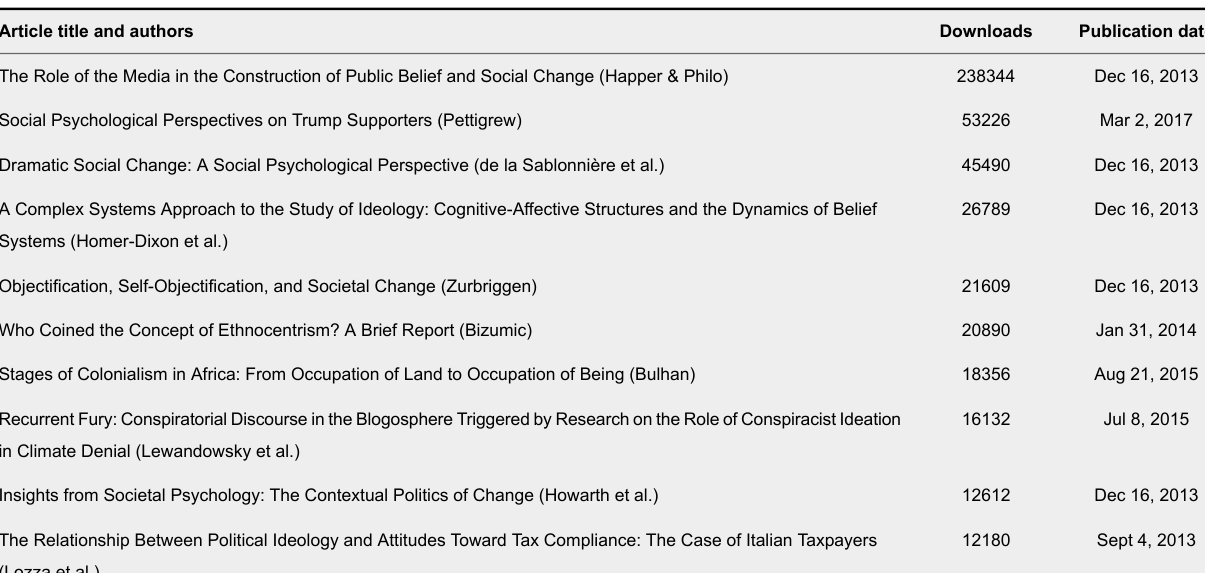
Top Ten Most Frequently Downloaded Articles Published Between 2013 and